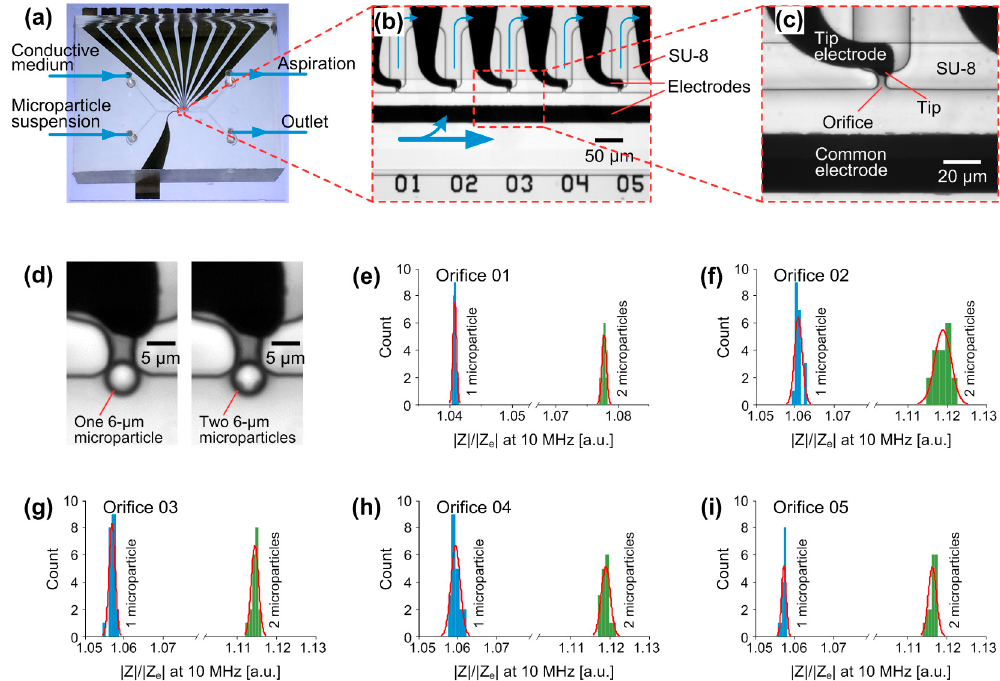
Figure 7. A metal-SU-8-PDMS hybrid device for multifunctional application. ( a ) Photo of the device indicated with the fluidic connections; ( b ) close-up of the device showing five orifices (01–05) and respective electrodes. The fluidic structures, patterned in SU-8, were precisely aligned with Pt electrodes. Blue arrows indicate the flow directions during the microparticle trapping; ( c ) close-up of a unit for microparticle trapping, nDEP releasing and local impedance measurement. The tip of the tip electrode is right situated under the orifice; ( d ) micrographs of one trapped microparticle and two vertically stacked microparticles. The diameter of microparticles used in this work is 6 µm; ( e – i ) identification of single and two vertically stacked microparticle(s) at the orifices 01 to 05 through impedance measurements. | Z | and | Z e | are the impedance magnitudes from measuring the trapped microparticle(s) and the empty orifice, respectively.